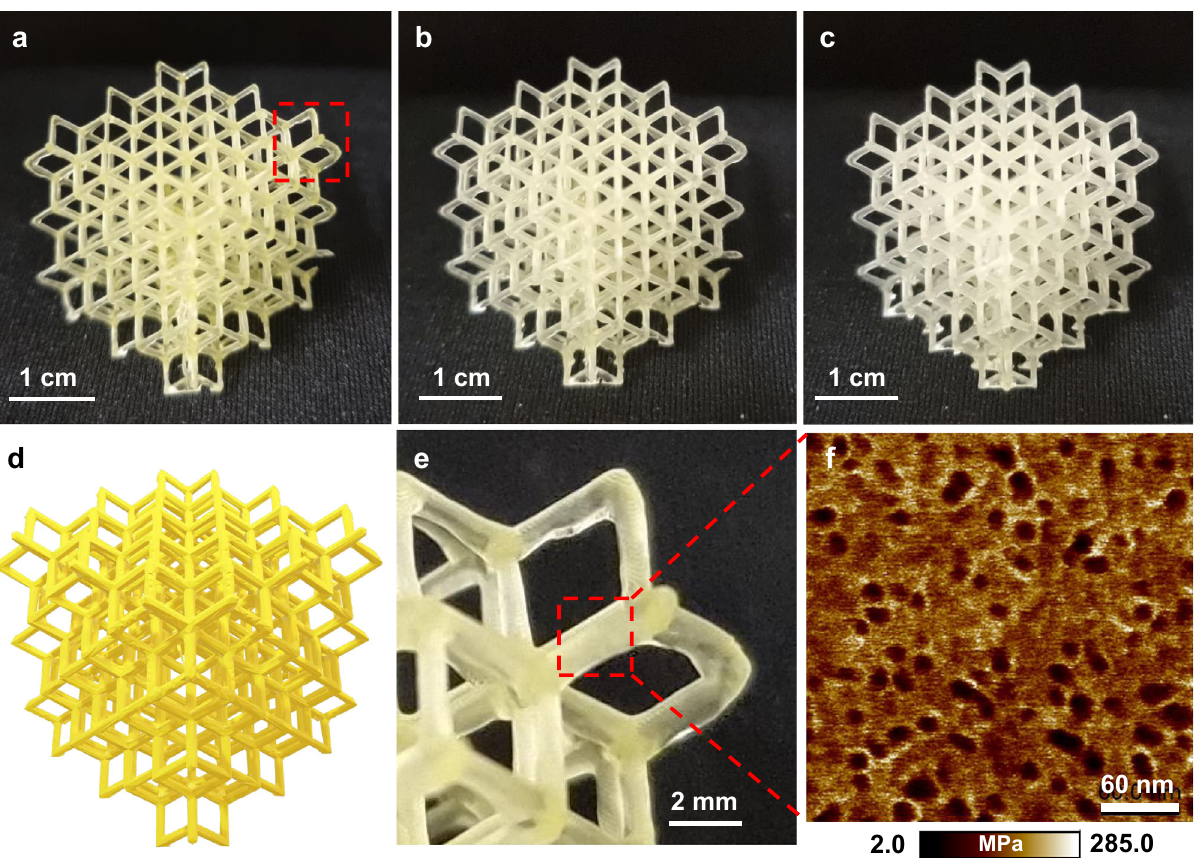
Fig. 7 3D print of a complex structure. Cubic lattice structures were 3D printed using PBA-CTAs with various degree of polymerization ( X n ): a X n = 48; b X n = 94; c X n = 180; d computer aided design of lattice structure to be 3D printed; e Close-up view and f surface morphology of 3D printed strut-based lattice structure using PBA 48 -CTA. Materials were 3D printed using a molar ratio of [AA]/[PEGDA] = 4/1 at 28.2 wt% loading of